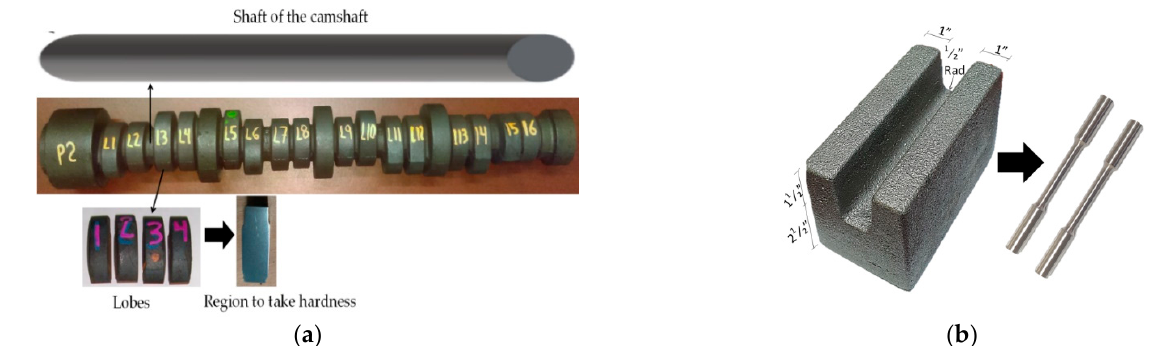
Figure 4. Samples obtained for mechanical tests from the ( a ) camshaft, ( b ) keel ‐ block casting.